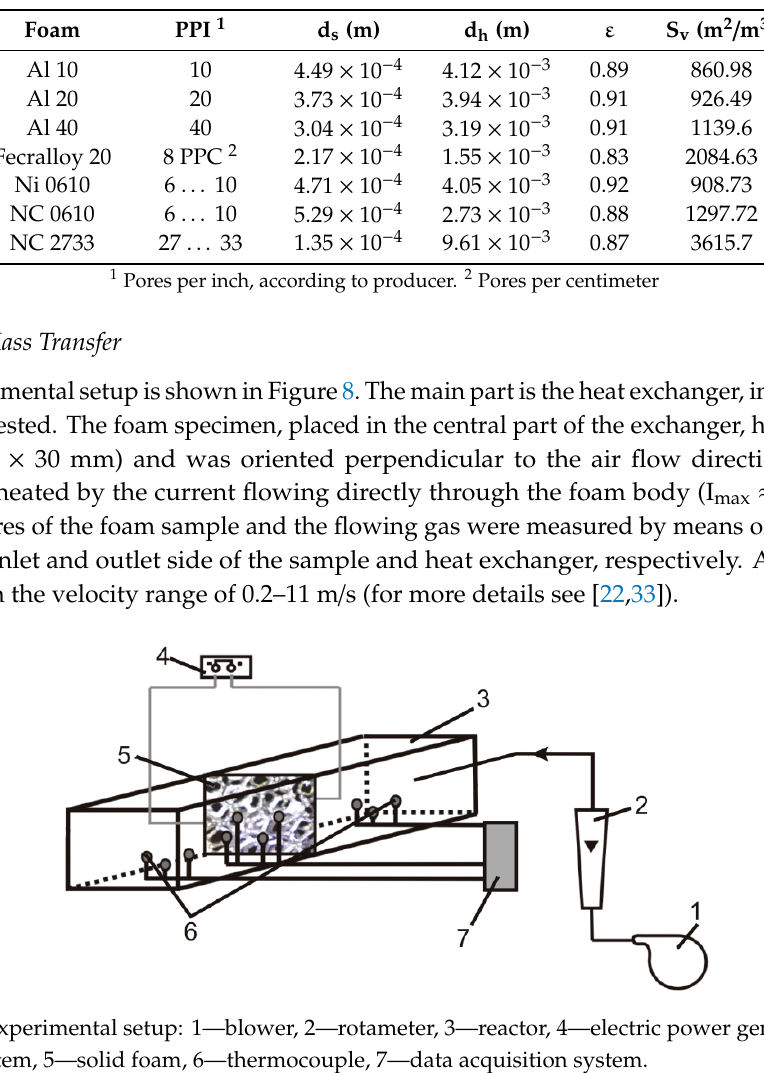
Table 3. Morphological parameters of foams tested.